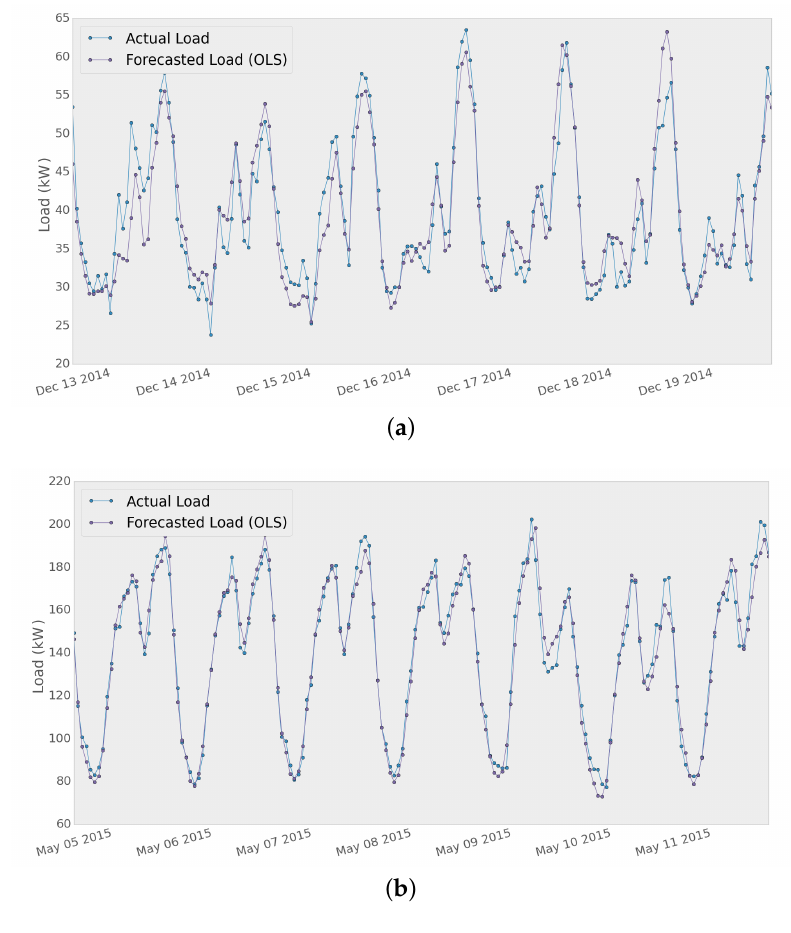
Figure 9. Load forecasting (24 h-ahead) for seven days at the secondary (MV/LV) substation: